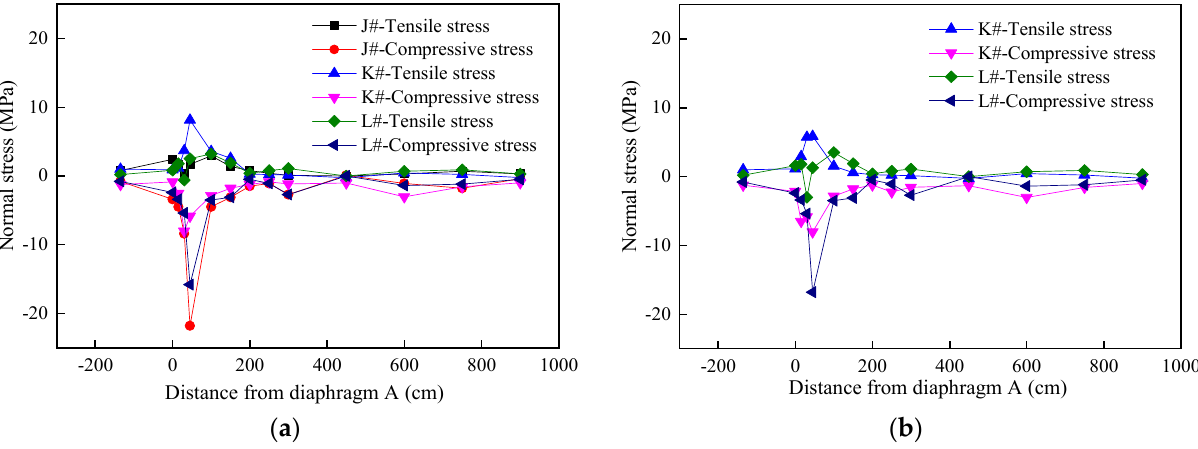
Figure 23. Longitudinal loading 100# diaphragm (steel reinforcement) bridge deck stress-load position relationship curve: ( a ) Before reinforcement, ( b ) after reinforcement.